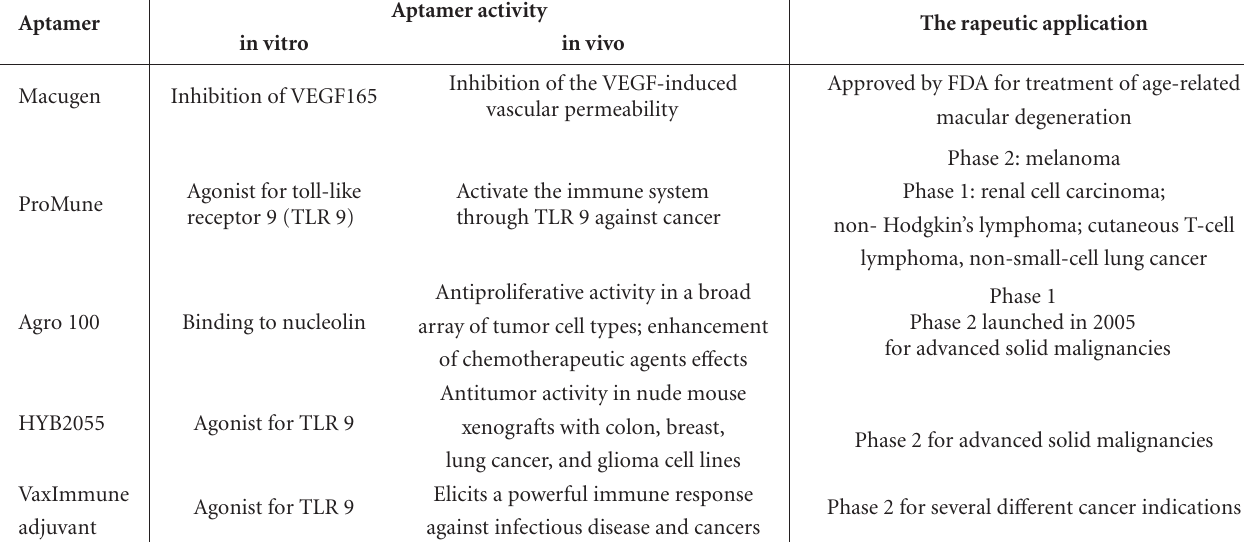
Table 1: Therapeutic aptamers in cancer